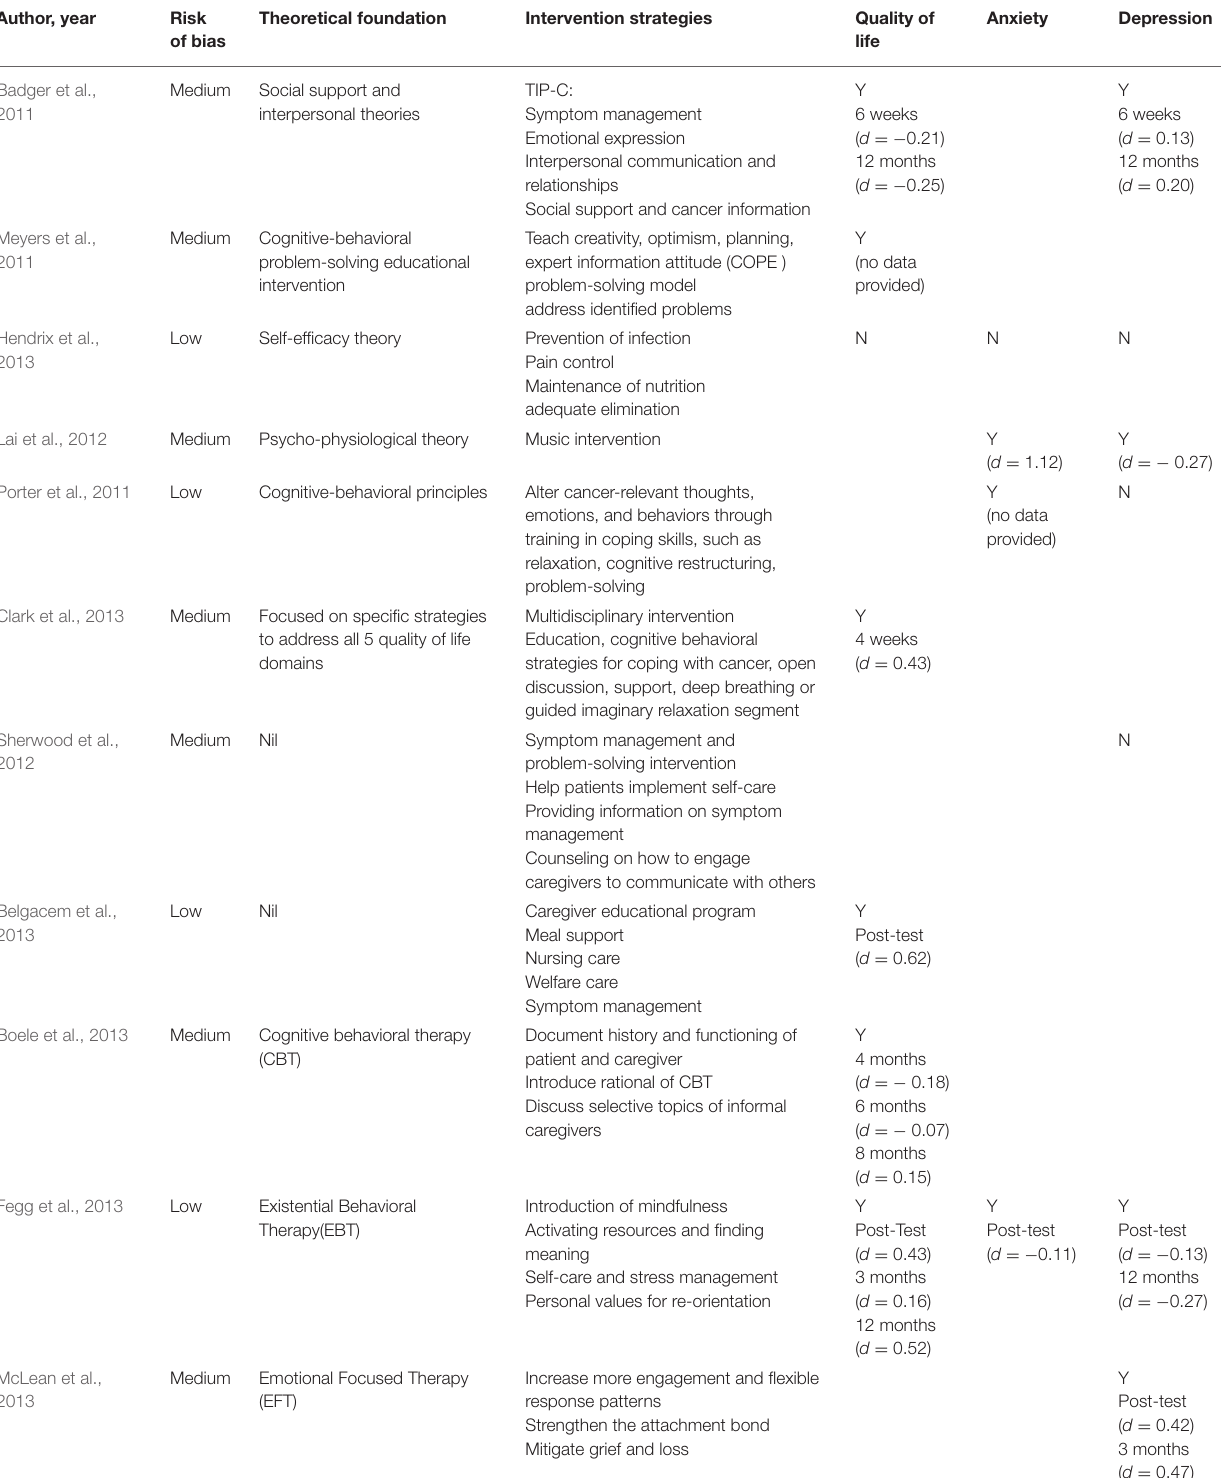
TABLE 2 | Significance of effectiveness of included